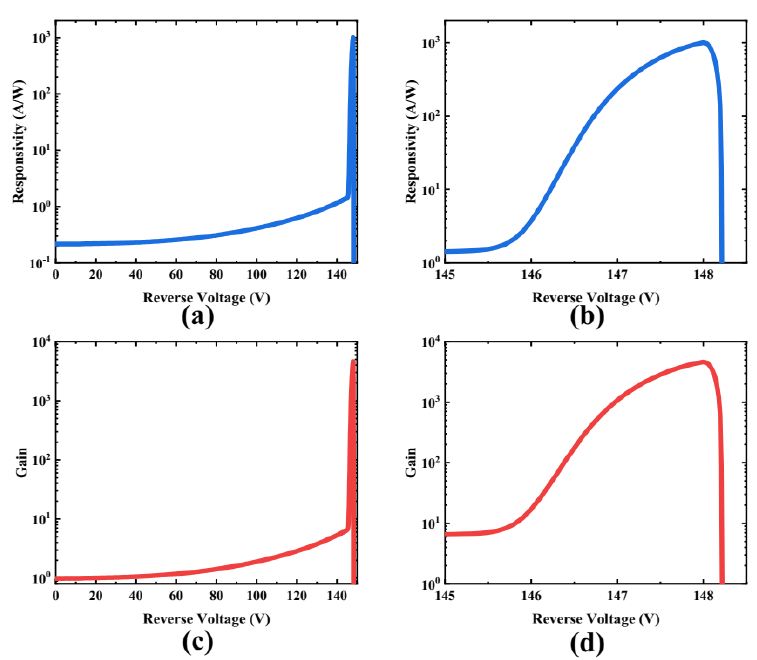
Figure 6. Static photoresponse of the Si APD: ( a ) responsivity versus reverse voltage; ( b ) responsivity near breakdown voltage; ( c ) net current gain versus reverse voltage; ( d ) net current gain near breakdown